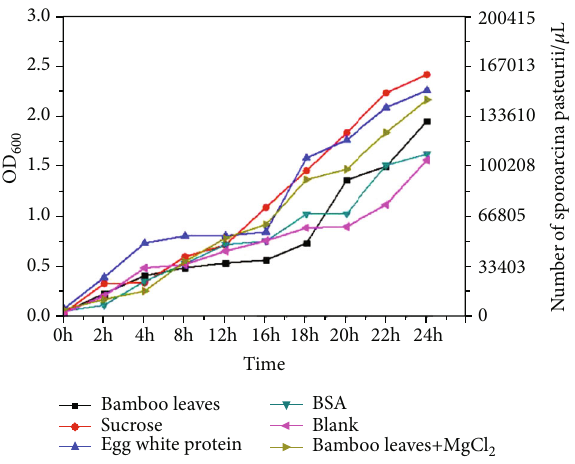
Figure 4: Variation chart of bacterium